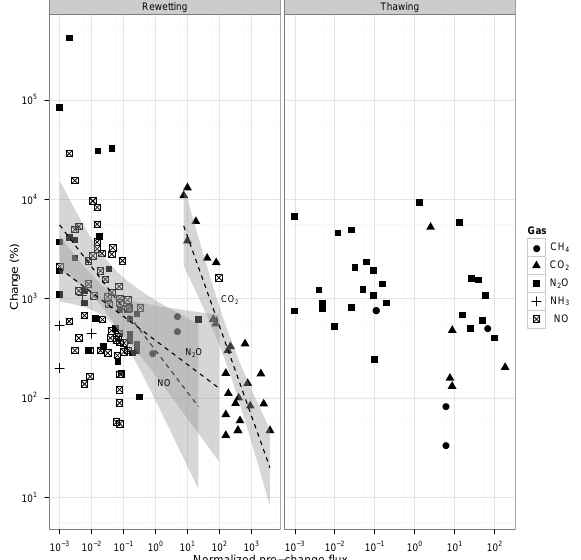
Fig. 6. Mean annual temperature versus flux change (i.e. peak flux as a percentage of pre-event flux), by gas and rewetting or thawing. Only statistically significant relationships (for CO 2 , N 2 O and NO on left, and N 2 O on right) are